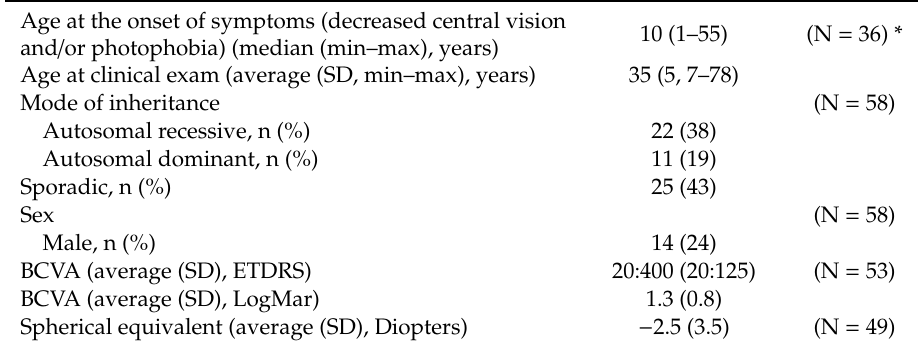
Table 1. Clinical characteristics of the cohort (N = 58